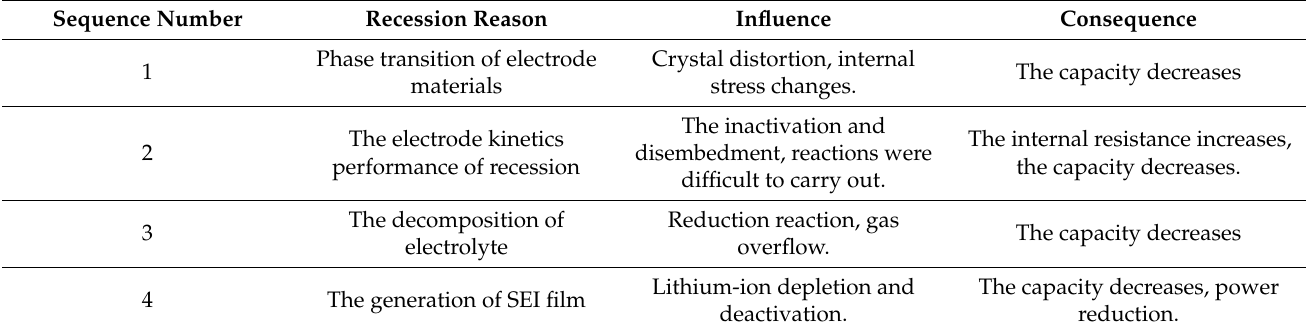
Table 1. Causes, effects and results of lithium-ion battery